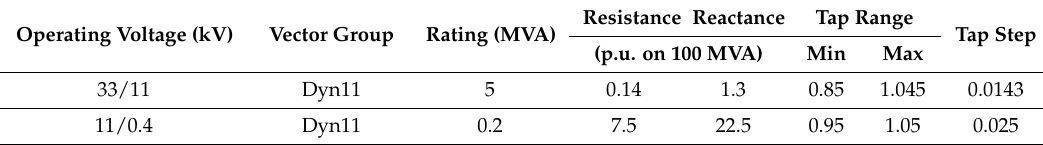
Table 2. Parameters of Typical MV/LV Transformers [22,28,30–32].